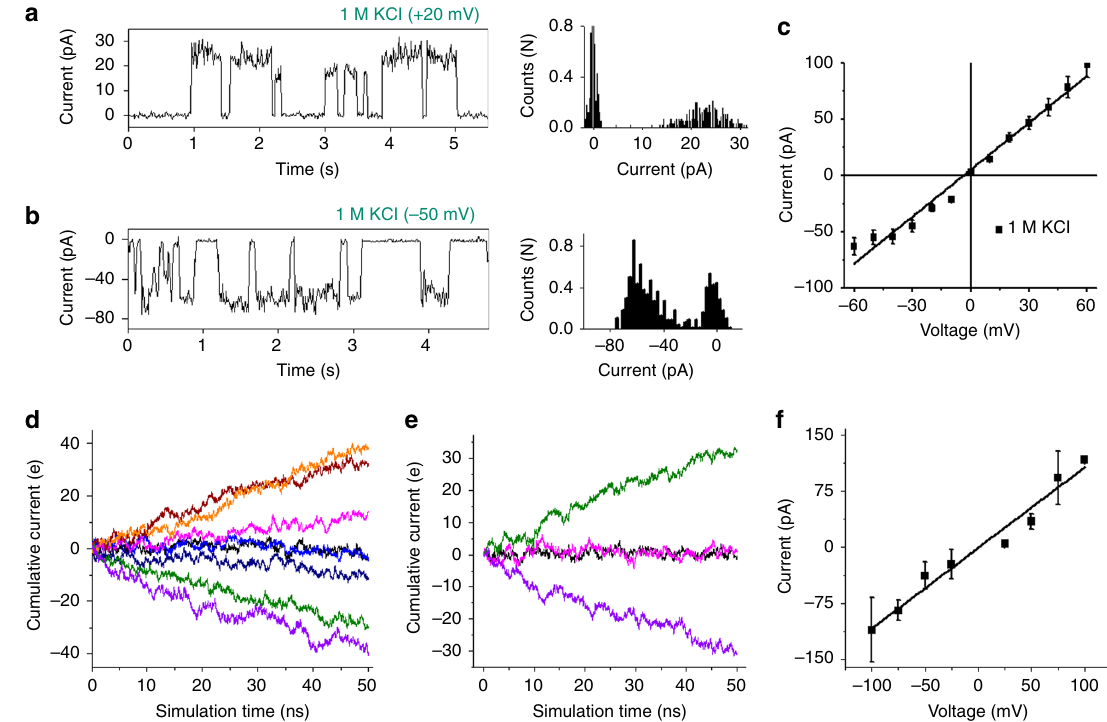
Fig. 4 Ion conductance studies across the lipid bilayer by MG/ h-TELO . Single-channel current traces recorded at + 20 mV ( a ) and − 50 mV ( b ) holding potentials in 1 M symmetrical KCl solution in the presence of MG/ h-TELO (60 μ M). All point histograms generated from the corresponding current traces at + 20 mV and − 50 mV have been presented on the right. c I − V plot using a voltage ramp ( − 60 mV to + 60 mV) in 1 M symmetrical KCl solution (black line) in the presence of MG/ h-TELO (60 μ M). Data are means ± SD ( n = 3). d Cumulative currents through the transmembrane pore resulting from the application of external electric fi elds. Orange, maroon, pink, black, light blue, deep blue, green, and purple color represent + 100 mV, + 75 mV, + 50 mV, + 25 mV, − 25 mV, − 50 mV, − 75 mV, and − 100 mV applied voltage biases. e Cumulative current fl ow for K + ions under the applied voltage biases of + 100 mV (green), − 100 mV (purple) and for Cl − ions under the applied voltage biases of + 100 mV (black), − 100 mV (pink). f Current/voltage characteristics of supramolecular transmembrane ionophore computed from molecular dynamics simulations under different applied voltage biases. Source data are provided as a Source Data fi le. Data represented as Mean ± SD ( n =